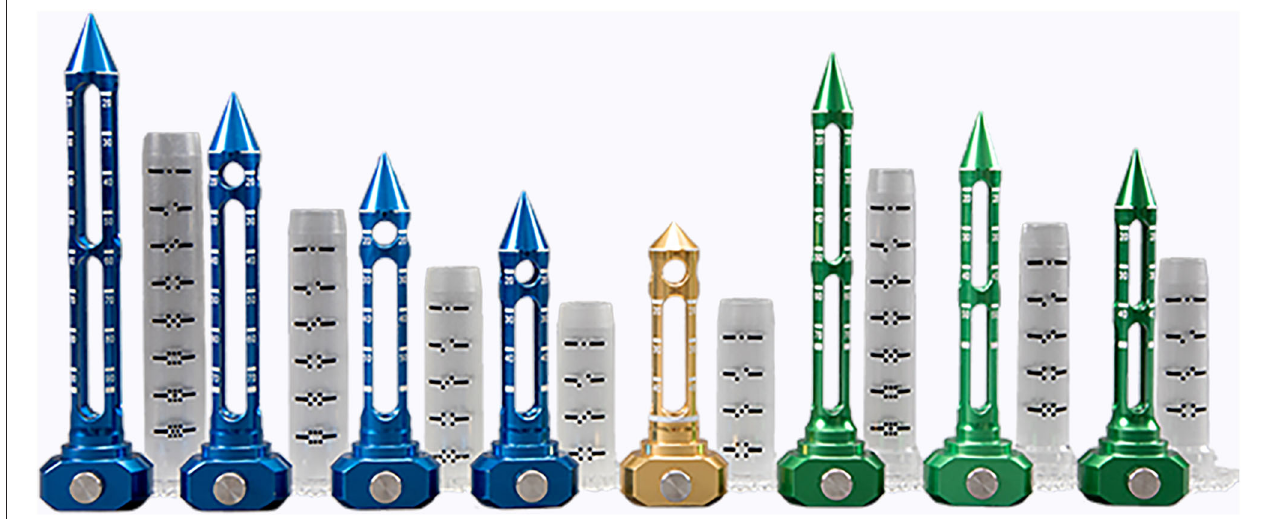
FIGURE 3 | The NICO BrainPath System consists of a 13.5mm diameter sheath with an internal dilator. The sheath and dilator have different lengths.